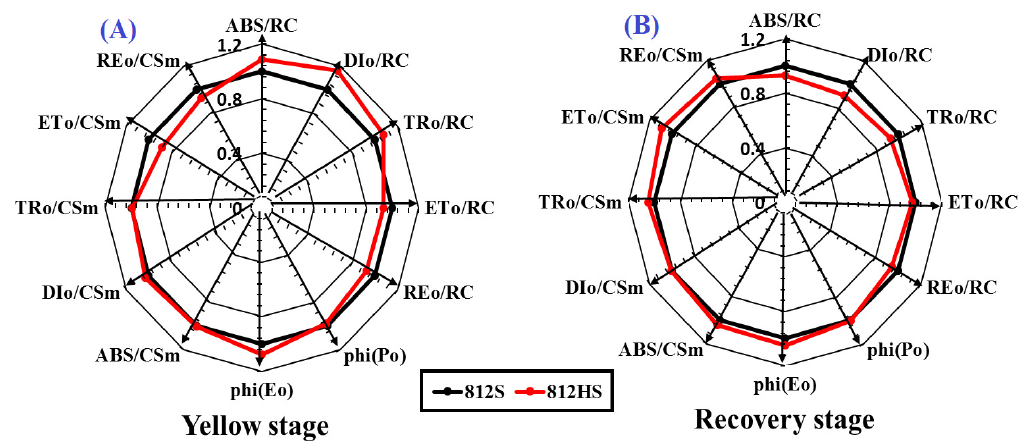
Figure 5. Fluorescence transient parameters characterized energy fluxes and flux ratios in leaves of 812HS and 812S in the yellow stage ( A ) and recovery stage ( B ).